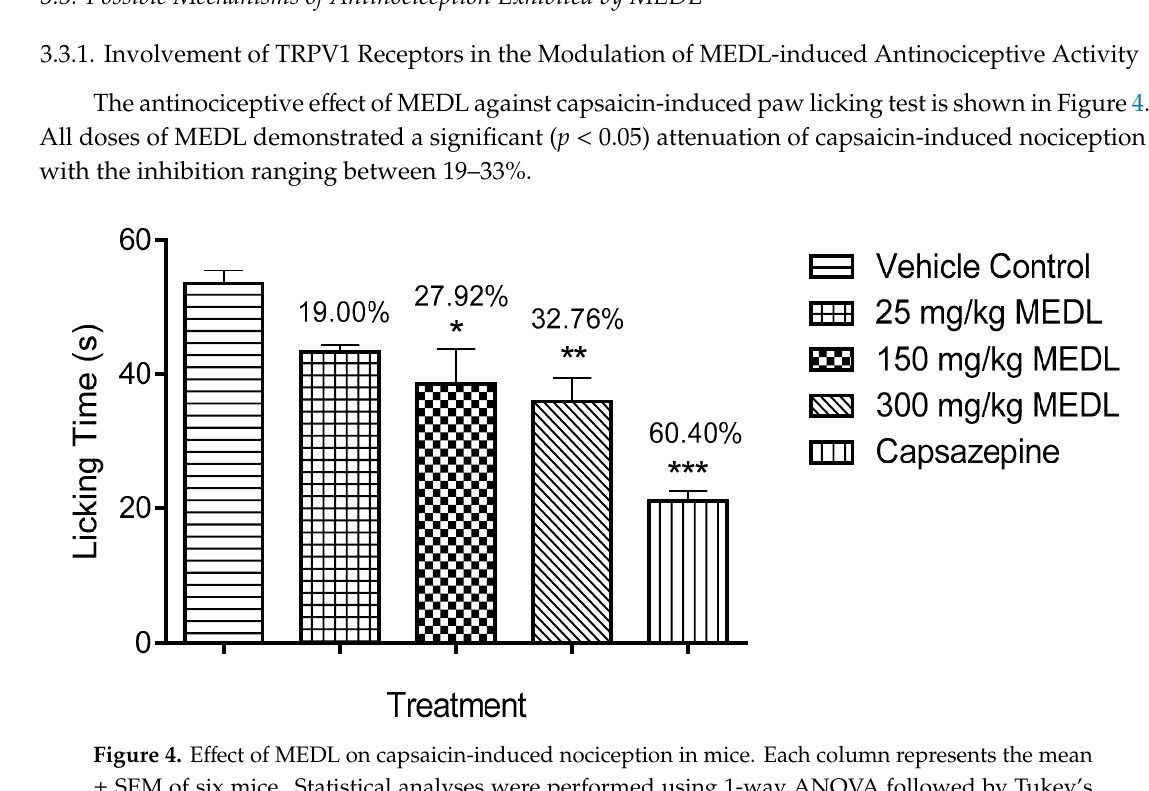
Figure 5. Effect of MEDL on glutamate-induced nociception in mice. Each column represents the mean ± SEM of six mice. Statistical analyses were performed using 1-way ANOVA followed by Tukey’s multiple comparisons test. * p ≤ 0.05 and *** p ≤ 0.001 compared to vehicle control group. Values on top of each column denote inhibition. 3.3.4. Involvement of PKC Pathway in the Modulation of MEDL-Induced Antinociceptive Activity MEDL was also found to exert significant ( p < 0.05) inhibition of PMA-induced nociception. However, this activity was observed only at the dose of 300 mg/kg with the recorded antinociception ranging between 5–36%. In comparison, 100 mg/kg ASA recorded the antinociception of approximately 54% (Figure 7).